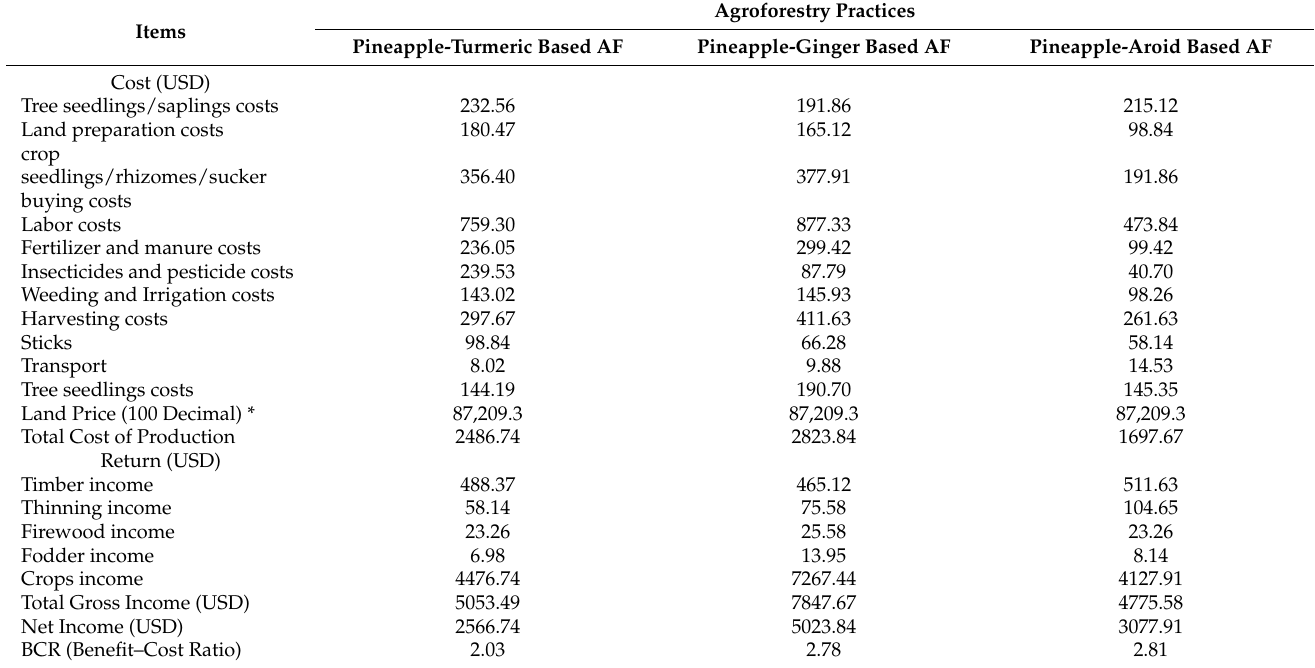
Table 1. Cost of production and income from fast-growing tree and shade-loving crops-based agroforestry practices.